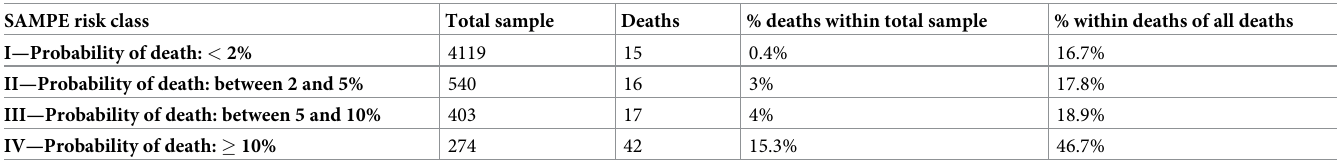
Table 4. Mortality by SAMPE Model risk